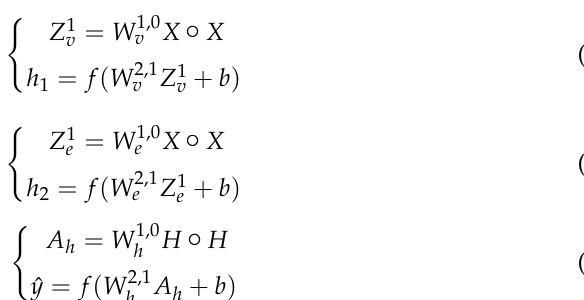
Figure 2. Dendrite module.